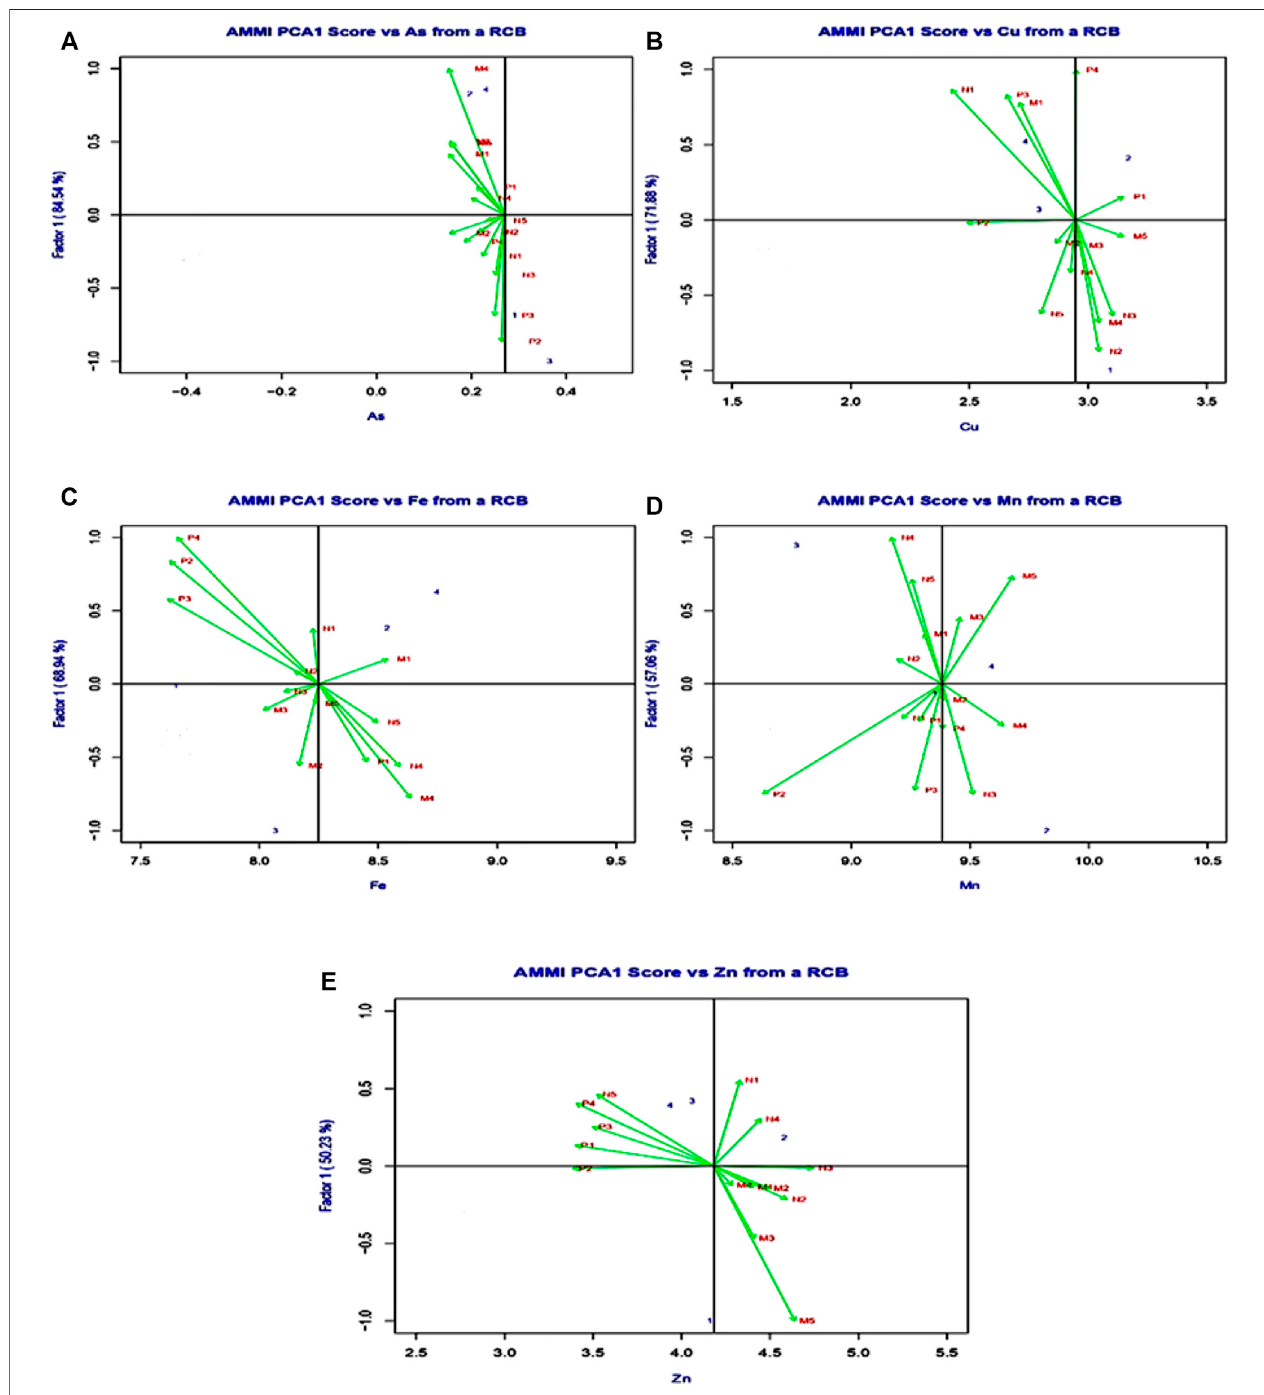
FIGURE 1 | Additive main effects and multiplicative interaction 1 biplots for selected metal and metalloids (A) As, (B) Cu, (C) Fe, (D) Mn, and (E) Zn found in 4 varieties in 14 locations. M1, Beldanga-I; M2, Beldanga-II; M3, Islampur; M4, Reginagar; M5, Domkol; N1, North Chandamari; N2, Porar Math; N3, Bamonbelia; N4, Kurumbelia; N5, Paschimer Math; P1, Guma; P2, Bira; P3, Prithiba; P4,